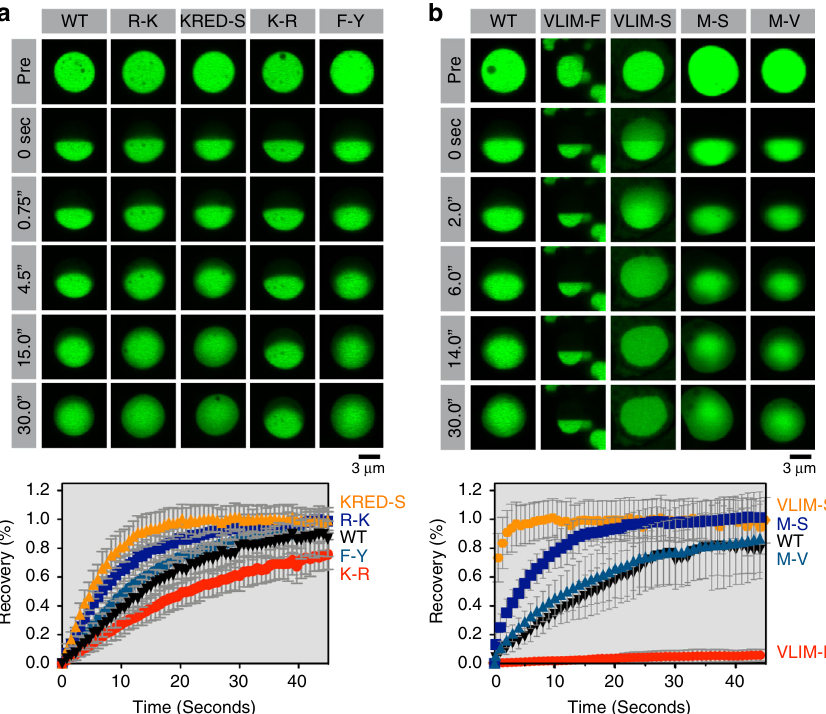
Fig. 4 π -interactions are important for phase separation of TDP43. a , b Half-bleach FRAP experiments to determine the impact of the indicated CTD mutations on the dynamics of TDP43 RRM-GFP droplets in transiently transfected HEK-293T cells. Plots show time-dependent, normalized fl uorescence recovery. Plot markers represent mean values and error bars standard deviation ( n ≥